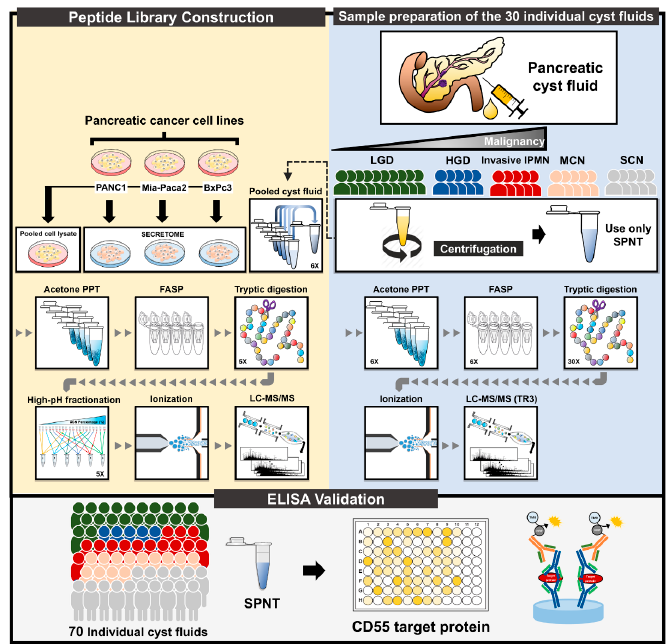
Figure 1. Experimental workflow. The overall experimental workflow comprises 3 sections: (1) Preparation of 30 individual samples, (2) peptide library construction, and (3) validation by ELISA. The cohort for label-free quantification included 30 pancreatic cyst fluid samples (10 LGD, 5 HGD, 5 invasive IPMN, 5 MCN, and 5 SCN). After mucus removal by sonication, the samples were centrifuged to isolate supernatant. Pooled cyst fluid (comprising equal amounts of 30 individual samples), secreted proteins from PANC1, Mia Paca-2, BxPC3, and pooled cell lysates from the 3 cell